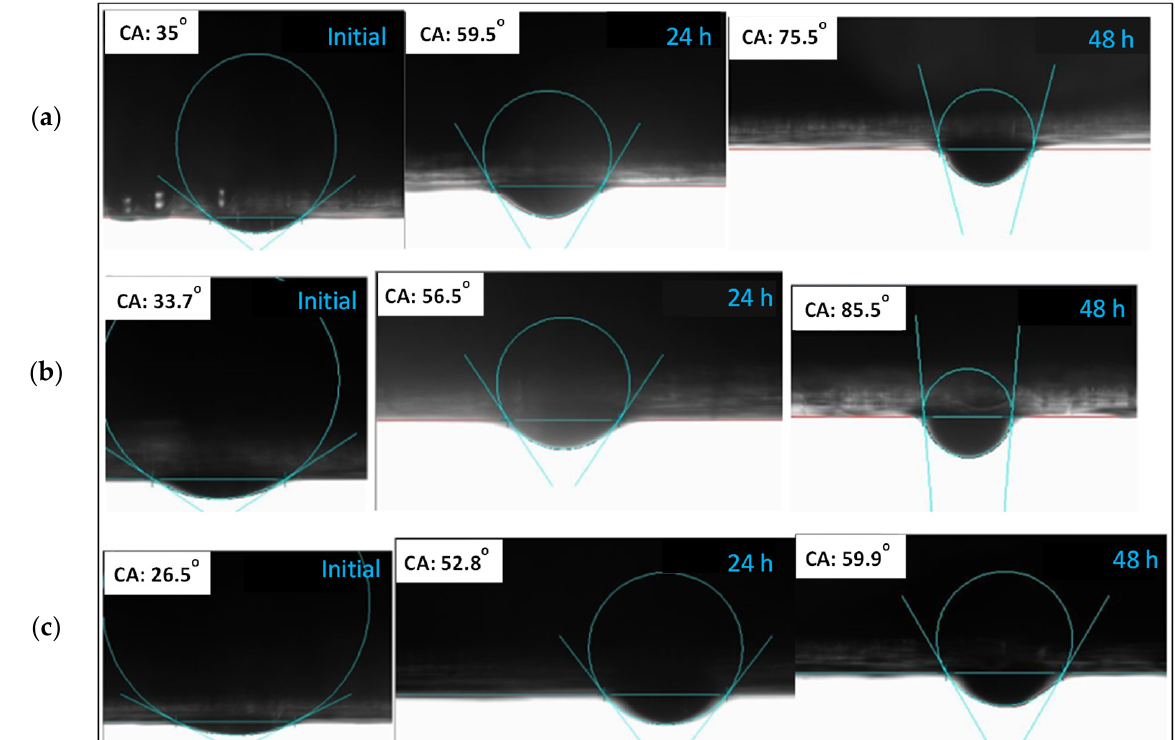
Figure 3. Contact angles for various nanofluid concentrations (0.05, 0.1, 0.15 wt%).